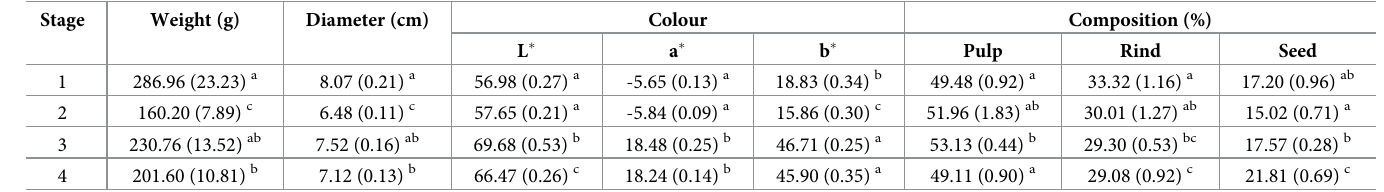
Table 1. Physical properties of S . madagascariensis fruit. The means for each parameter are reported under the respective stages of maturity followed by the standard error in brackets. Means accompanied by the same letter in a given column are not significantly different (P > 0.05). Stage Weight